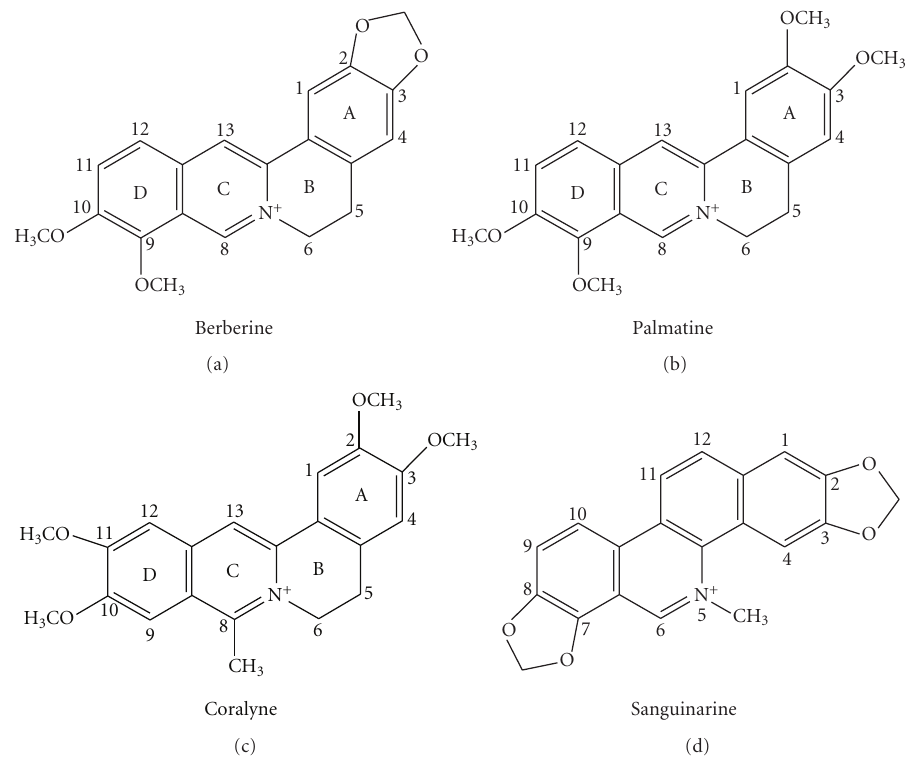
Figure 1: Chemical structures of isoquinoline